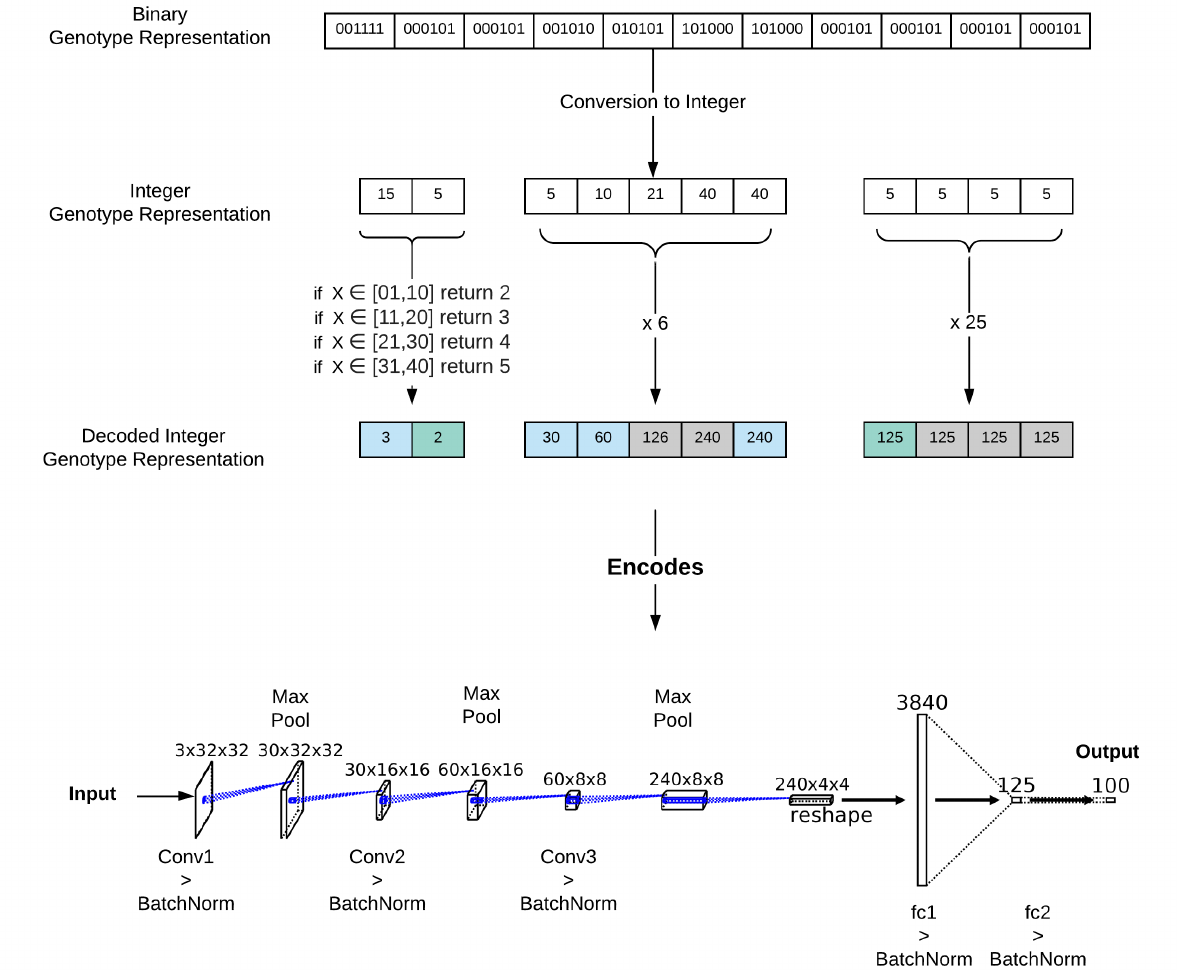
Figure 3. Decoding the genotype representation of the baseline